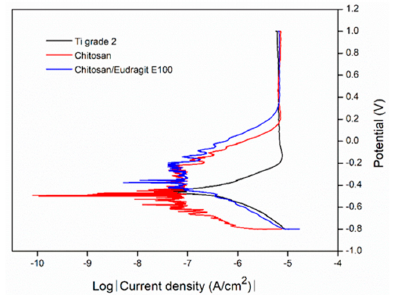
Figure 8. Potentiodynamic polarization curves of uncoated Ti grade 2 substrate, chitosan, and chit/EE100 (A1 sample) coatings in ASS at 37 °C temperature. Table 5. Open circuit potential, corrosion potential, and current density of the Ti grade 2 substrate and coated substrate with chitosan and chit/EE100 (sample A1) . Sample OCP (V) E corr (V)